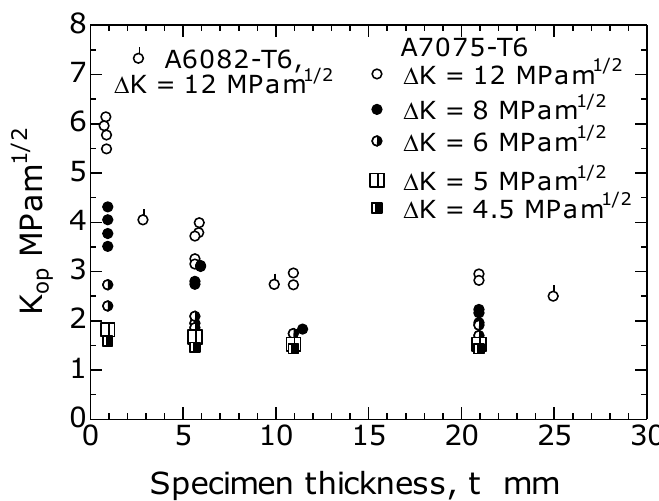
Figure 8. Effect of t on K op (R = 0.1).